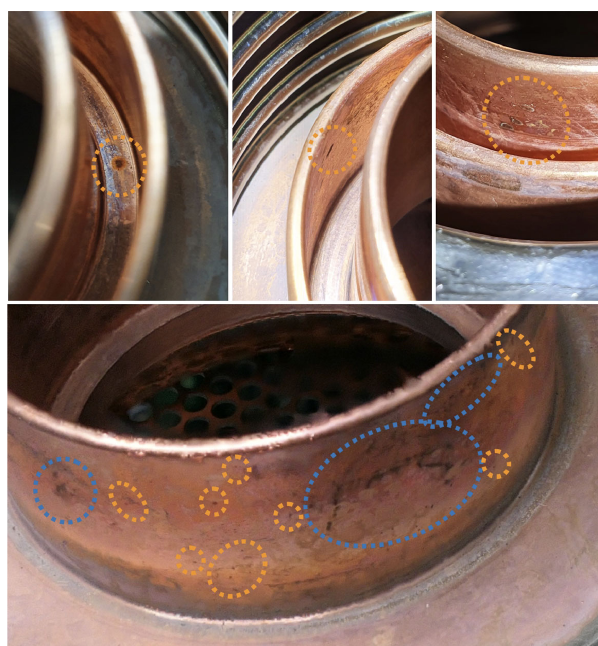
FIG. 16. Spot-sized (orange) and extended (blue) discolorations found on the labyrinth surfaces of CSB1 after